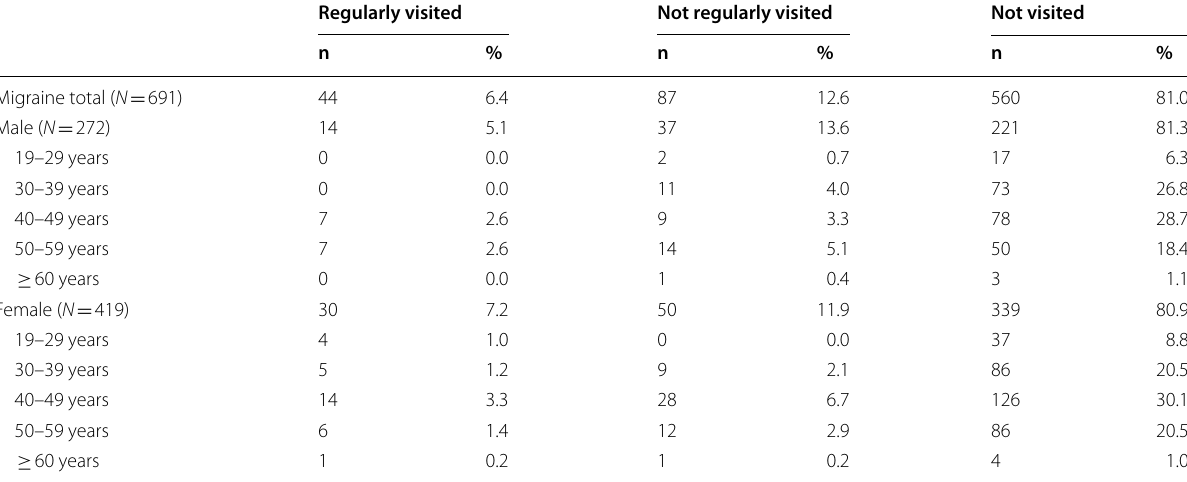
Regularly visited